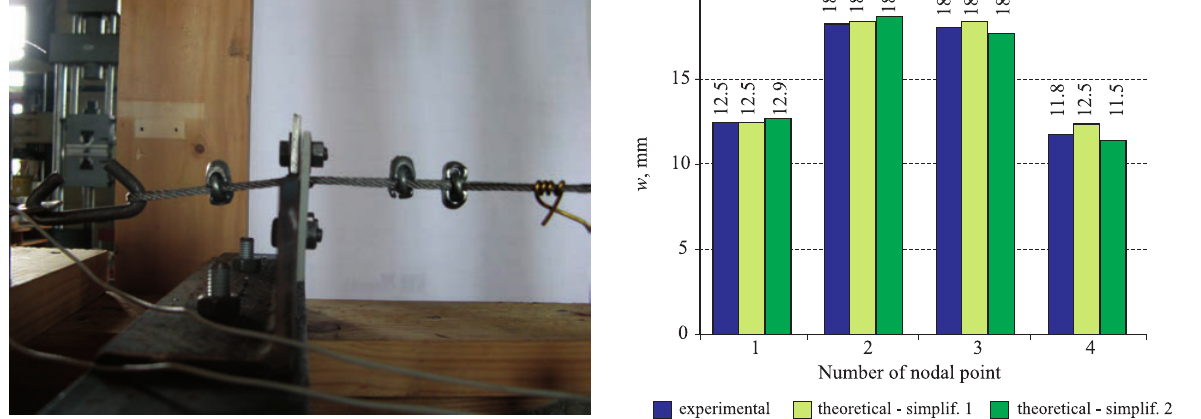
Fig. 8. Support of the cable